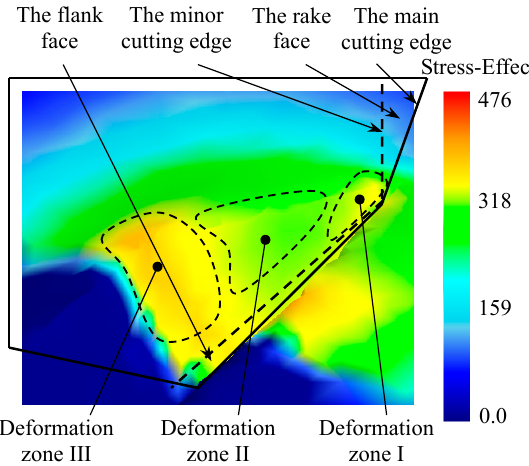
Figure 9. Deformation zones in the process of fin forming.